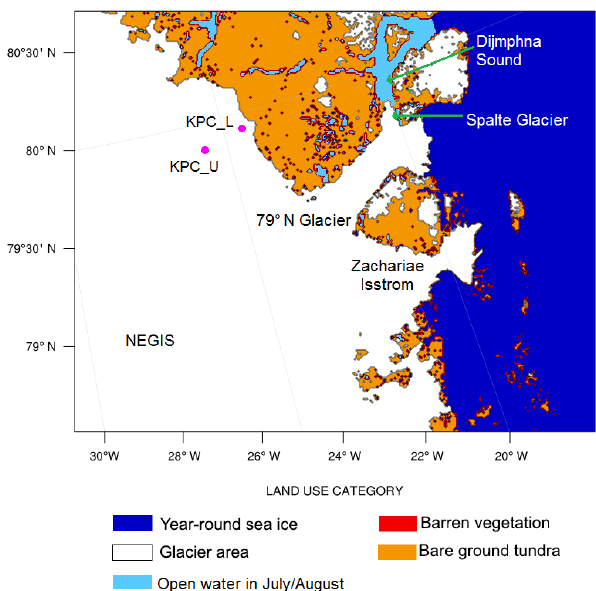
Figure 2. A map of the land use types for D03. Colours represent the land use type, except for light blue, which highlights the man- ually changed land use from open water to sea ice during winter. Important locations are also highlighted, as are the locations of the two AWS sites (pink